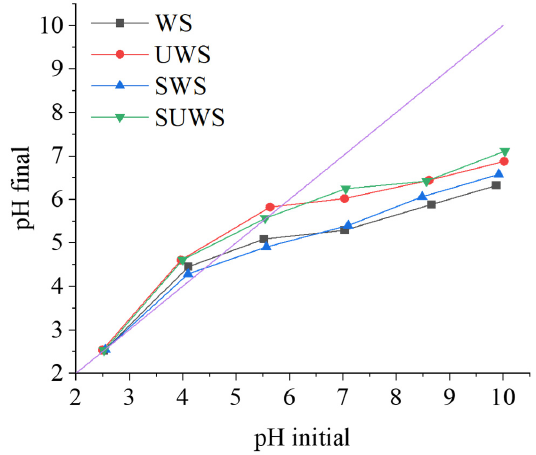
Figure 2. Curves of point zero charge determination of biosorbents. When the pH of the medium is lower than pHpzc, it is expected that the biosorbent surface will be predominantly positively charged. As a result, less CV dye can be adsorbed as electrostatic repulsion will increase between the positively charged adsorbent and the cationic dye. Furthermore, at low pH, there is also competition for the adsorption sites between -H+ groups, which are present in a large amount, and the cationic dye. The SDS modi fi cation yielded SWS and SUWS with similar, albeit lower, pHpzc values of 4.4 and 5.6, respectively. Our results show similar trends as those in the study of Lim et al. [45], in which native Artocarpus odoratissimus skin had a pH of 4.9, however, after alkaline treat- ment the pH increased to 6.6 while the SDS treatment decreased it to 4.7. According to the obtained pHpzc values for biosorbents, the estimated pH range for maximum CV removal is between 6 and 8, since the surface of biosorbents is negatively charged and dyes are positively charged (pKa of CV 8.5–8.6). Furthermore, the adsorption processes for WS, SWS, UWS and SUWS are expected to be similar since these samples have similar charge environments.